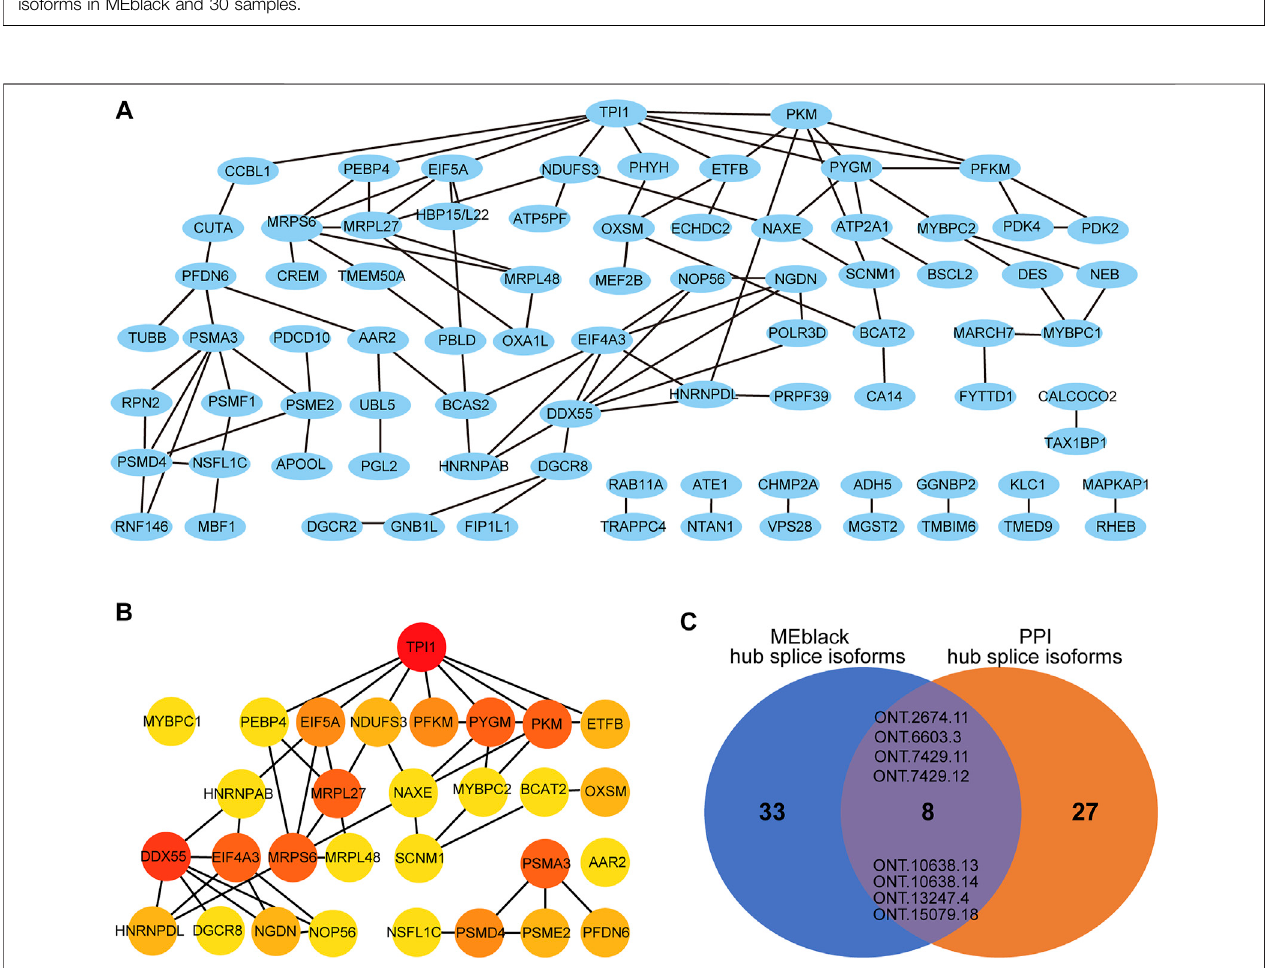
FIGURE8| Co-expressionandPPIanalysisresults. (A) Thegene-PPInetworkofsplicingisoformsinMEblack; (B) ThePPInetworkoftheDegreetop30gene; (C) The venn diagram of the hub splicing isoforms of MEblack and the hub splicing isoforms of PPI.